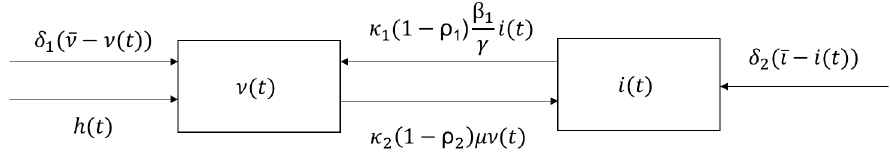
Figure 1. Diagram of model (2) showing the variables and their interaction